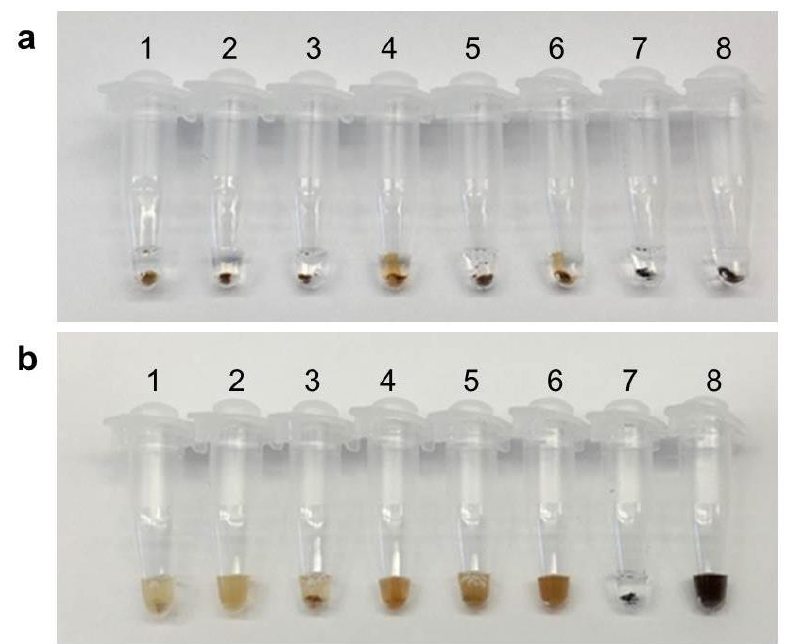
Figure 3. Agglomeration reaction of magnetic beads: 1~2, Dynal MyOne; 3~4, SPRI beads; 5~6, Magbio beads; 7~8, HMP; 2, 4, 6, 8 serve as negative control; ( a )The agglomeration reaction before vortex; ( b ) The agglomeration reaction after vortex.